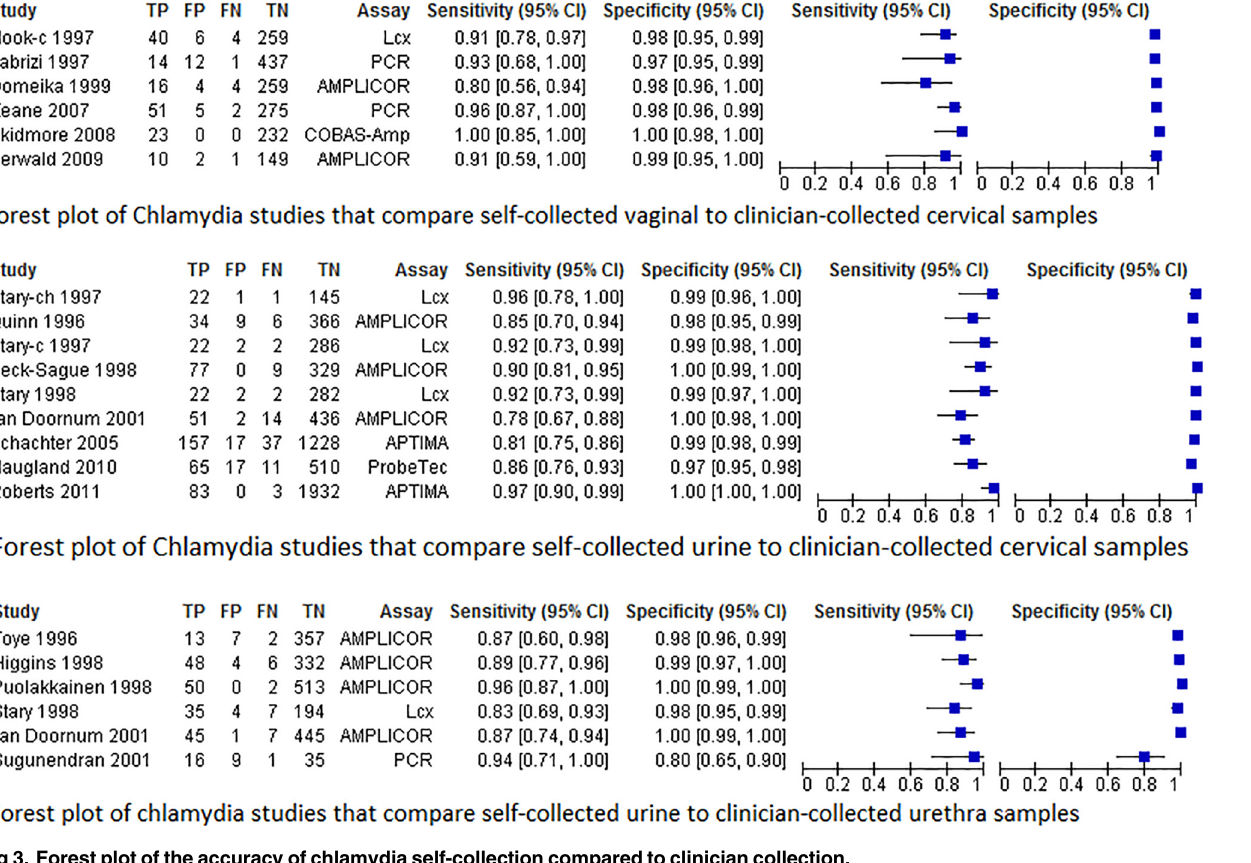
Fig 3. Forest plot of the accuracy of chlamydia self-collection compared to clinician